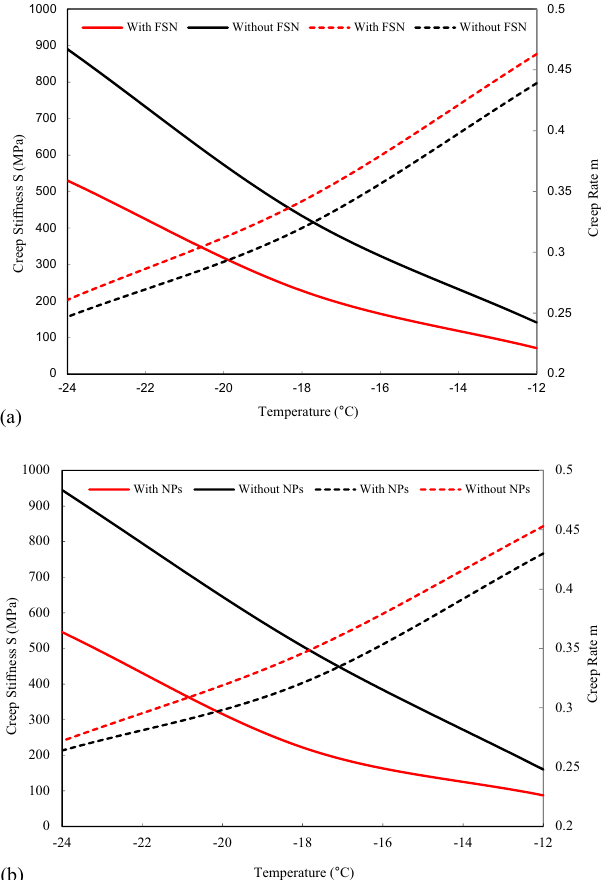
Figure 4. Analysis of Bending Beam Rheometer tests: Creep Stiffness (S) and Creep Rate (m) of binder modified with fumed silica nanoparticles (FSN) ( a ) before and ( b ) after long-term aging at different